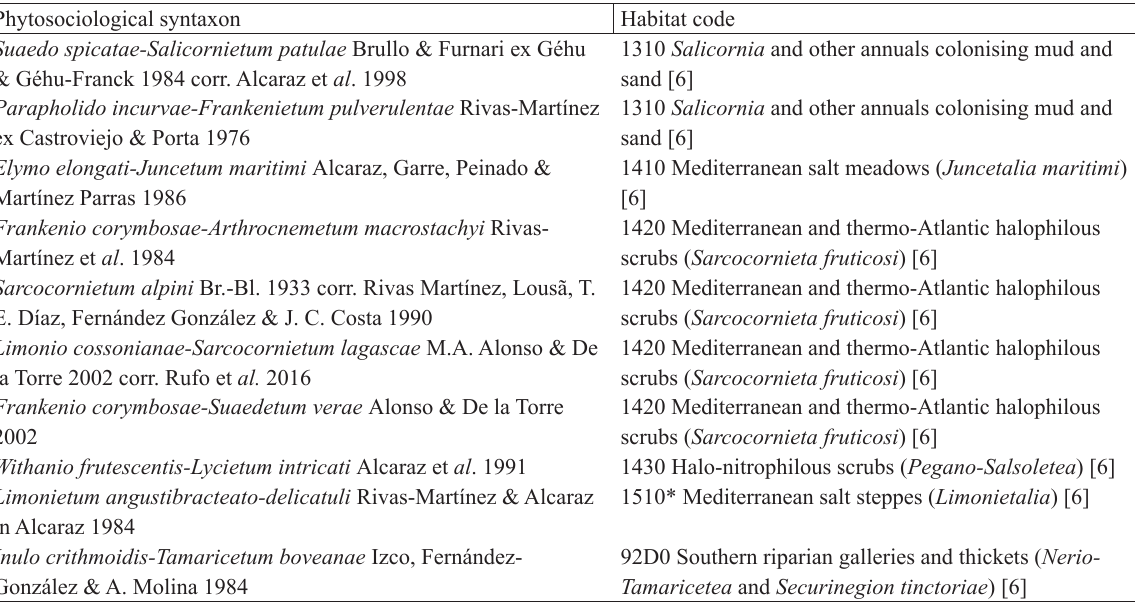
Table 2. Saltmarsh plant communities of Punta Entinas-Sabinar, Almería. Phytosociological syntaxon Habitat